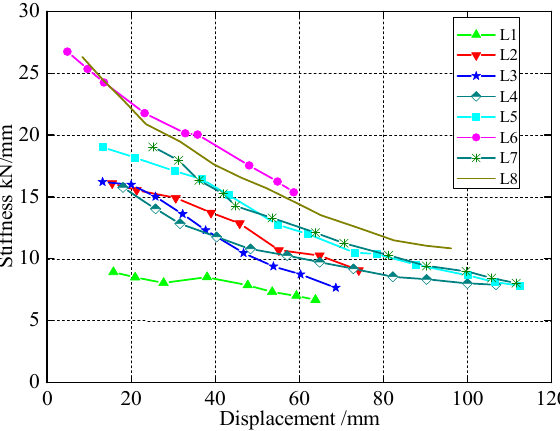
Figure 12. Stiffness degradation curve of each test specimen.